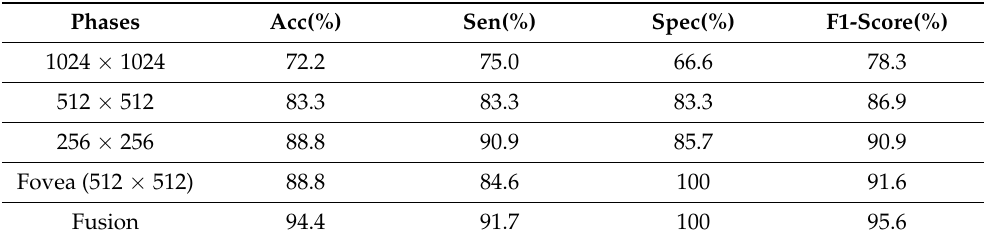
Table 2. The ACC(%), Sen(%), Spec(%), and F1-score(%) for the proposed DR classifier with multiple size. ACC = accuracy, Sen = sensitivity, and Spec =